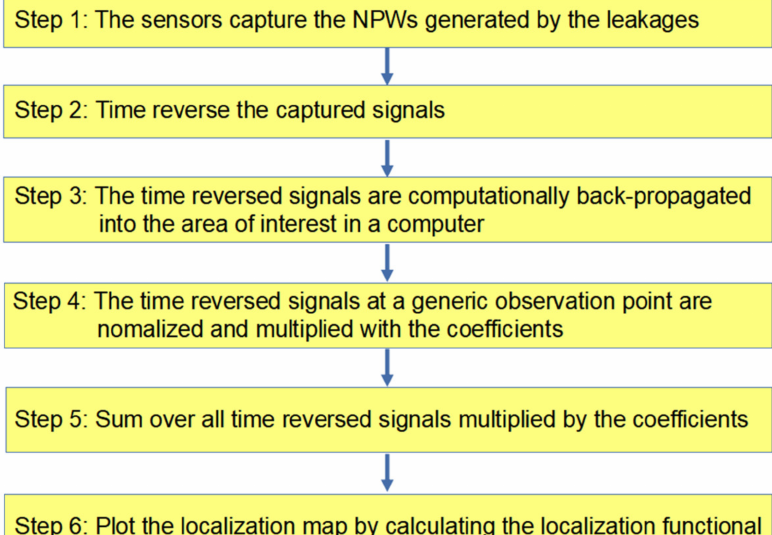
Figure 3. The procedure of the localization